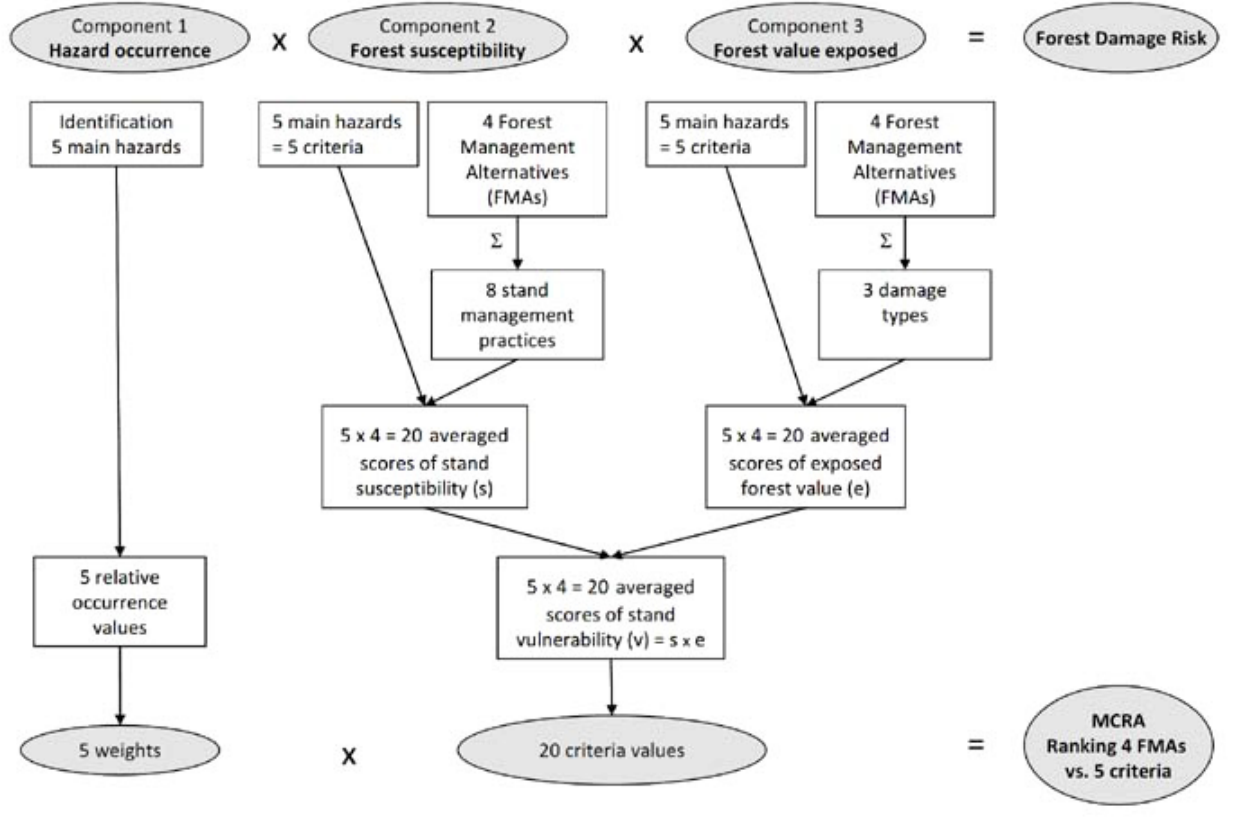
Fig. 1. Conceptual flow diagram of MCRA methodology for a given regional case study.